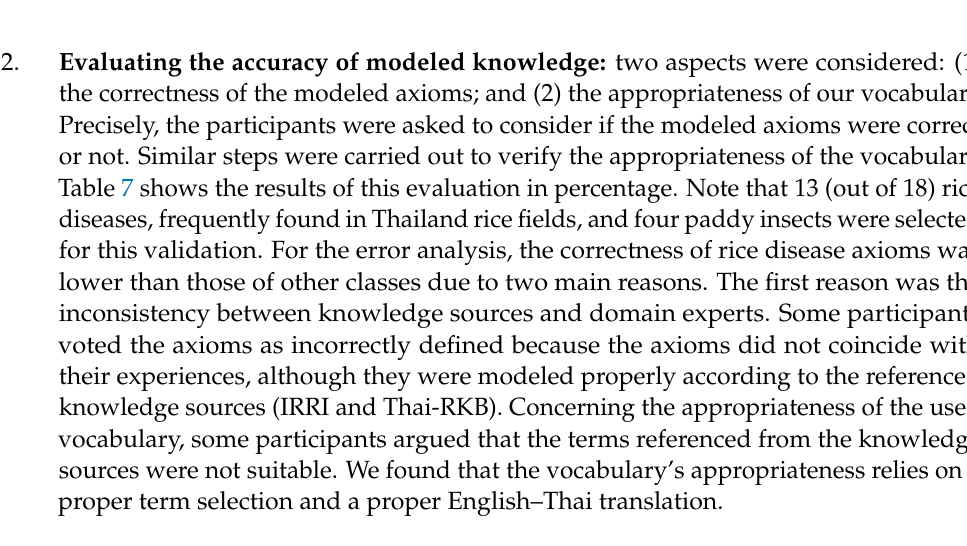
Table 7. Accuracy of the modeled